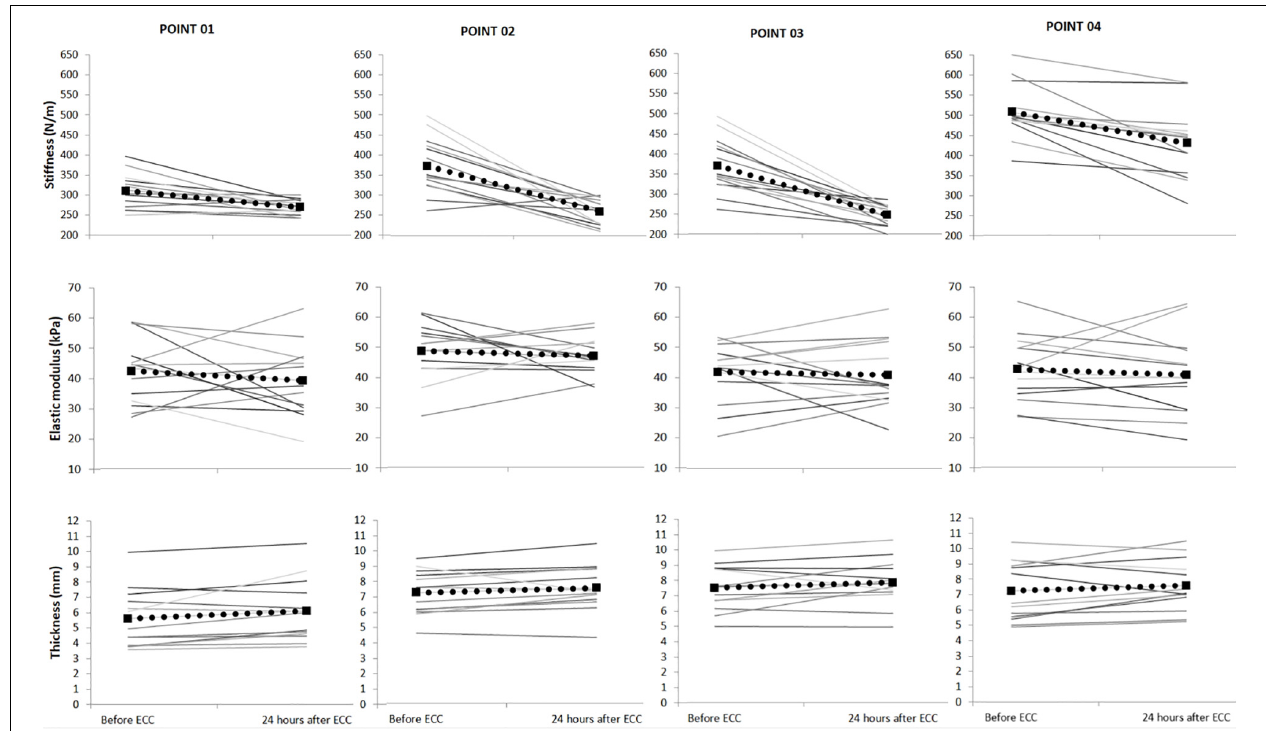
FIGURE 2 | Mean (SD) muscle dynamic stiffness measured by myotonometry, elastic modulus measured by shear-wave elastography and muscle thickness measured by ultrasonography ( N = 14), before and 24 h after eccentric exercise (ECC). Each gray line represents dynamic stiffness, elastic modulus and thickness variability for each of the participants. The dotted line represents the group